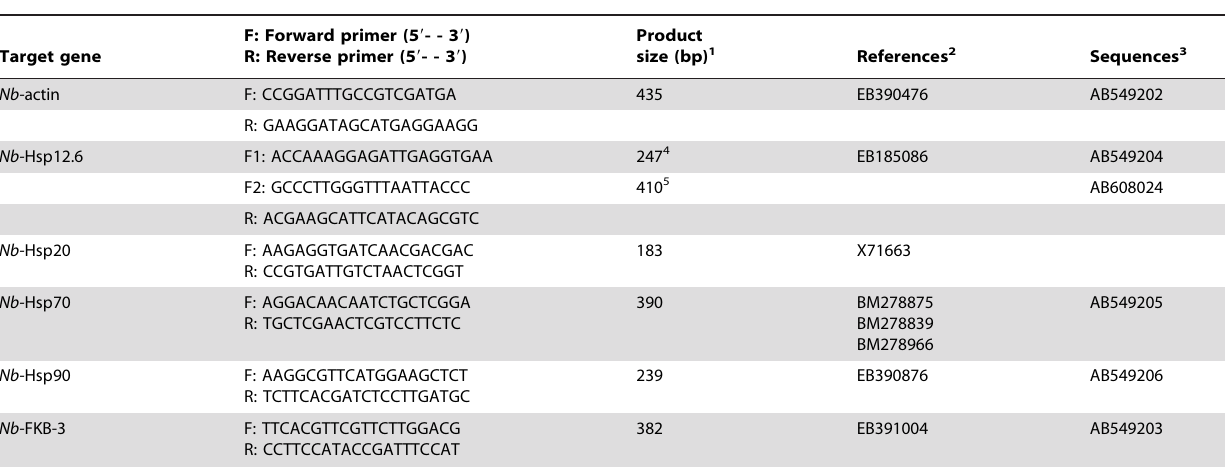
Hsps, FKB-3, and actin of Nippostrongylus brasiliensis cDNA of the putative Nb -Hsp12.6, Nb -Hsp20, Nb -Hsp70, Nb - Hsp90, Nb -FKB-3, and Nb -actin were amplified by PCR using the primers listed in Table 2, and nucleotide sequences were determined. Although the target sequences did not include the entire coding region (except that of Nb -Hsp12.6), protein motif/ domain searches revealed that the translated amino acid sequences of Nb -Hsp12.6, Nb -Hsp20, Nb -Hsp70, Nb -Hsp90, Nb -FKB-3, and Nb -actin showed unambiguous matches to the respective protein families (Table 3). Further, 3D models were constructed based on the amino acid sequences of Nb -Hsp12.6 and Nb -FKB-3 and these were compared with the 3D structure of C. elegans Hsp12.6 and FKB-3 (Figure S4: the 4th supporting information figure). A (MOE) program showed the 3D structural difference (RMSD) Table 2. Primers used in this study.